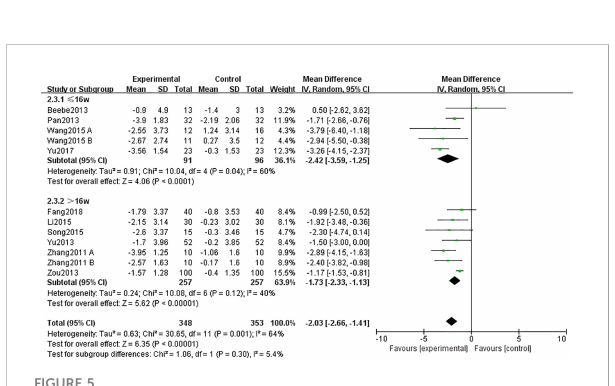
FIGURE 5 Forest plots and subgroup analysis for traditional Chinese exercise (TCE) on body mass index (BMI).